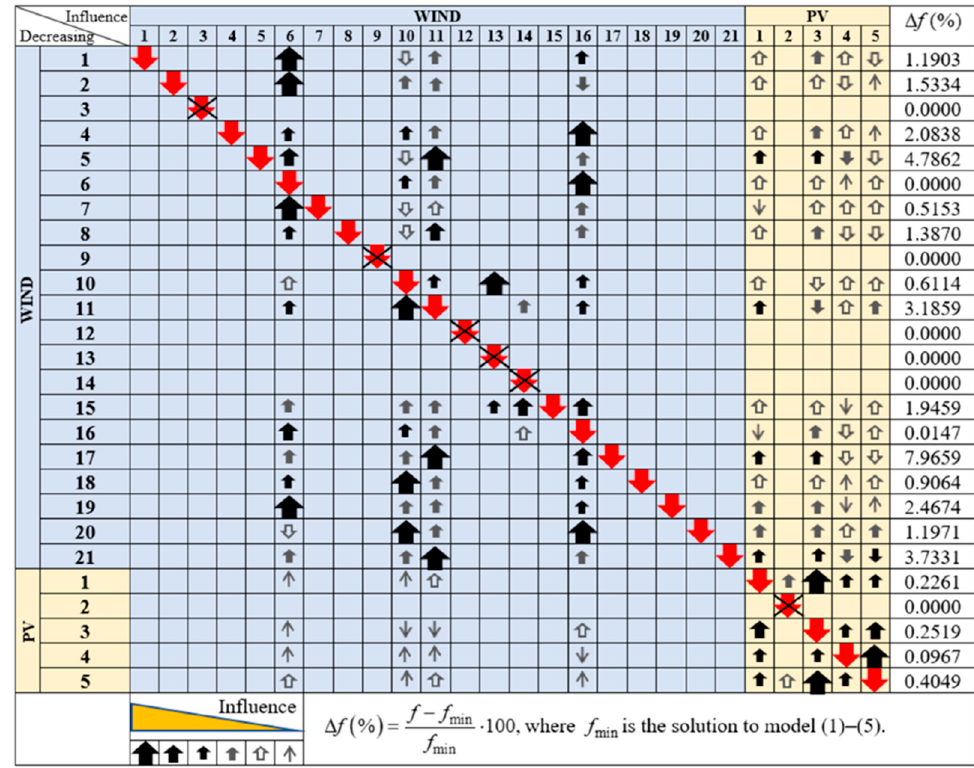
Figure 14. Means to reduce the effect on the sum of squared errors when decreasing the capacity in exactly one region.